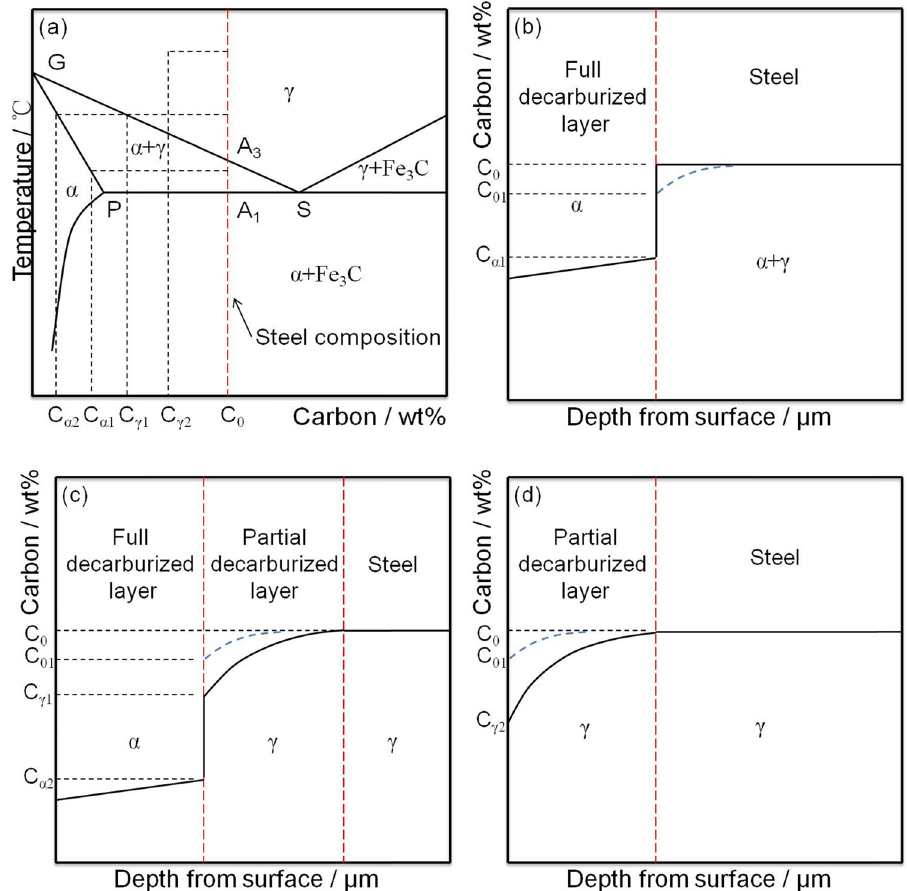
Figure 7: Schematic of decarburization for di ff erent temperature ranges: ( a ) Fe – C phase diagram. Decarburization schematic: ( b ) A1 < T < A3, ( c ) A3 < T < G, and ( d ) G <